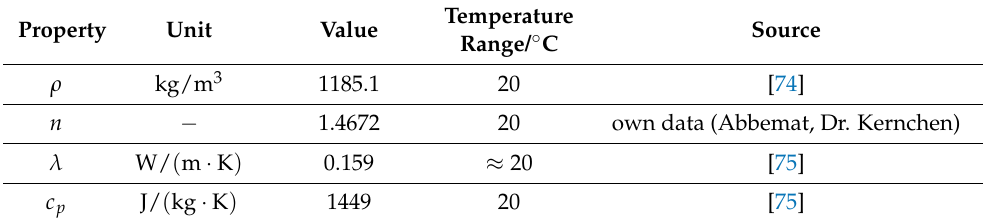
Table A2. Material properties of pure poly(vinyl acetate).